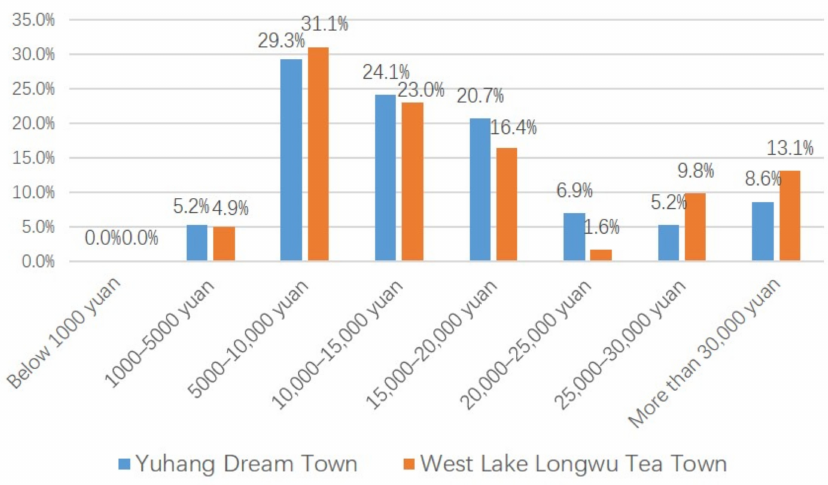
Figure 8. Household monthly income distribution of respondents (source: